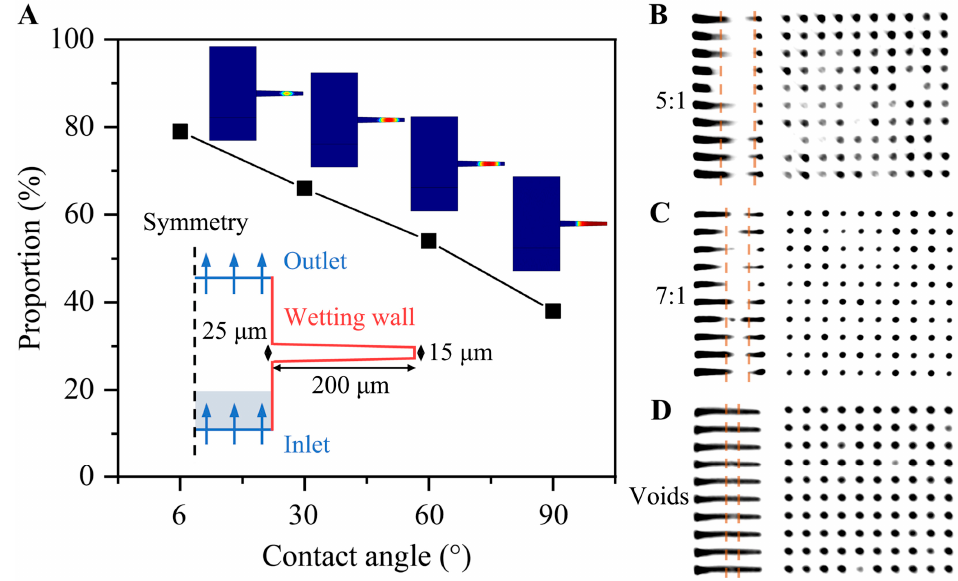
Figure 4. ( A ) Relationship between the contact angle of the wetting wall and self ‐ wetting volume proportion of the electrolyte in TDV. ( B – D ) 2D ‐ CT scans of the Cu ‐ filled TDV at 0.45 ASD without any pretreatment, with vacuum ‐ assisted prewetting treatment, and with Ar/O plasma ‐ combined vacuum ‐ assisted prewetting, respectively.